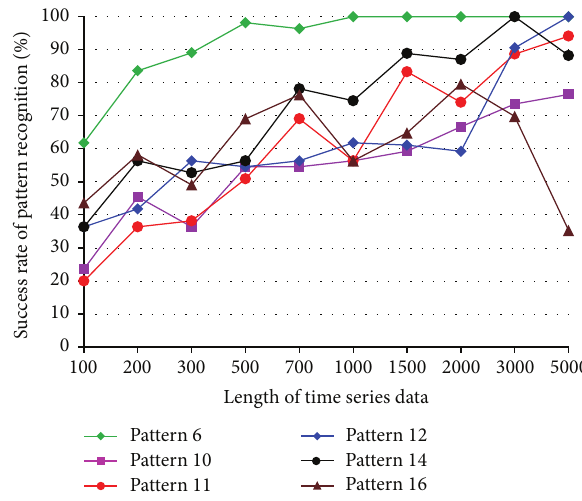
Figure 13: Success rate of pattern recognition using DFT-based feature extraction in second